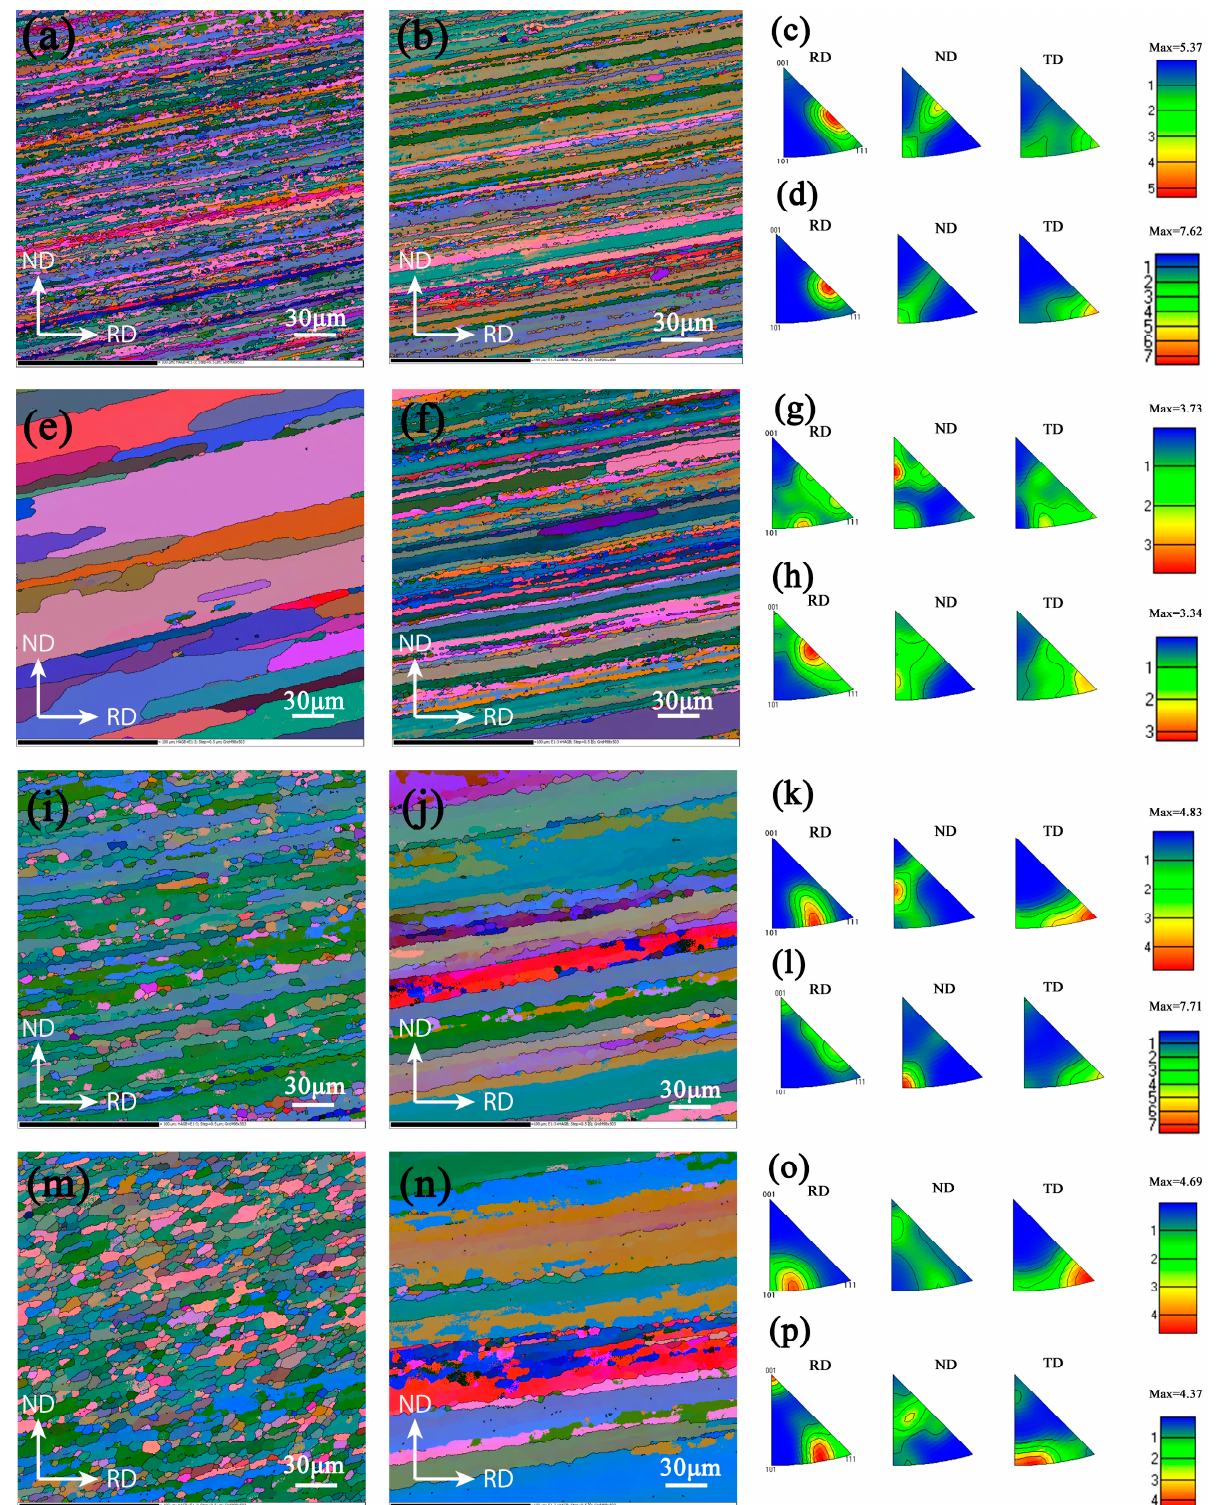
Figure 2. Orientation maps of 7B05 aluminum alloy based on EBSD measurements: ( a ) T4-6 sur- face microstructure, ( b ) T4-6 center microstructure, ( c ) T4-6 IPF of surface, ( d ) T4-6 IPF of center; ( e – h ) the corresponding T4-15 EBSD microstructures; ( i – l ) the corresponding T5-10 EBSD microstruc- tures; ( m – p ) the corresponding T5-15 EBSD